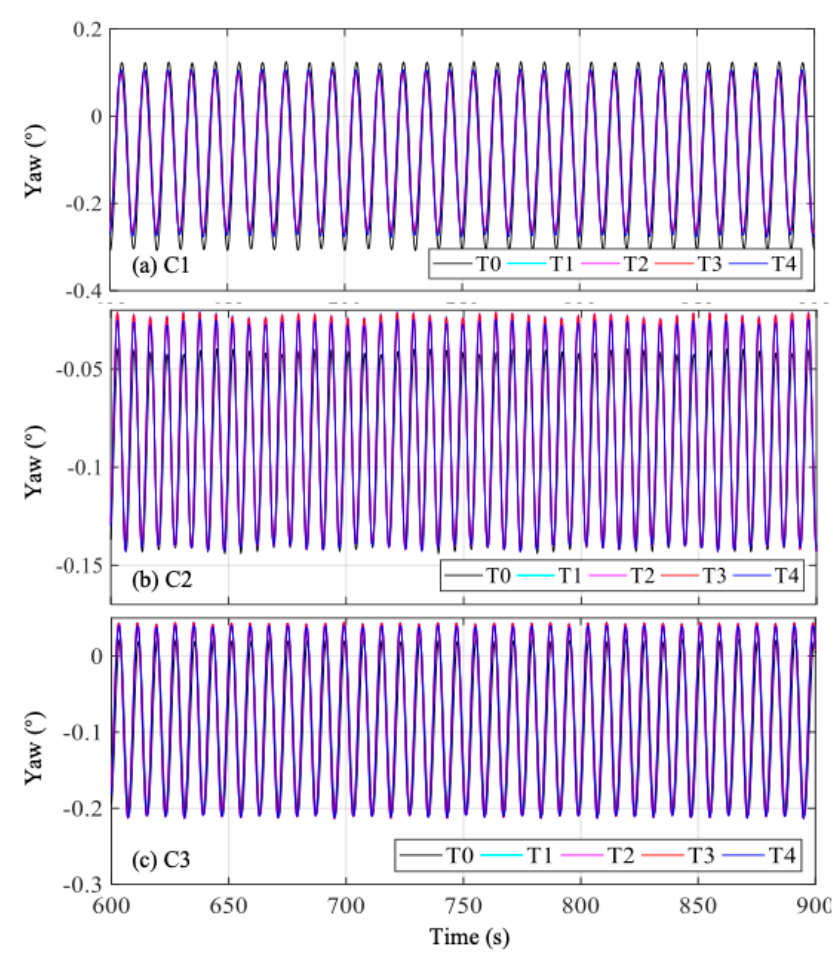
Figure 9. Wind turbine yaw movement time series in ( a ) C1, ( b ) C2, and ( c ) C3.